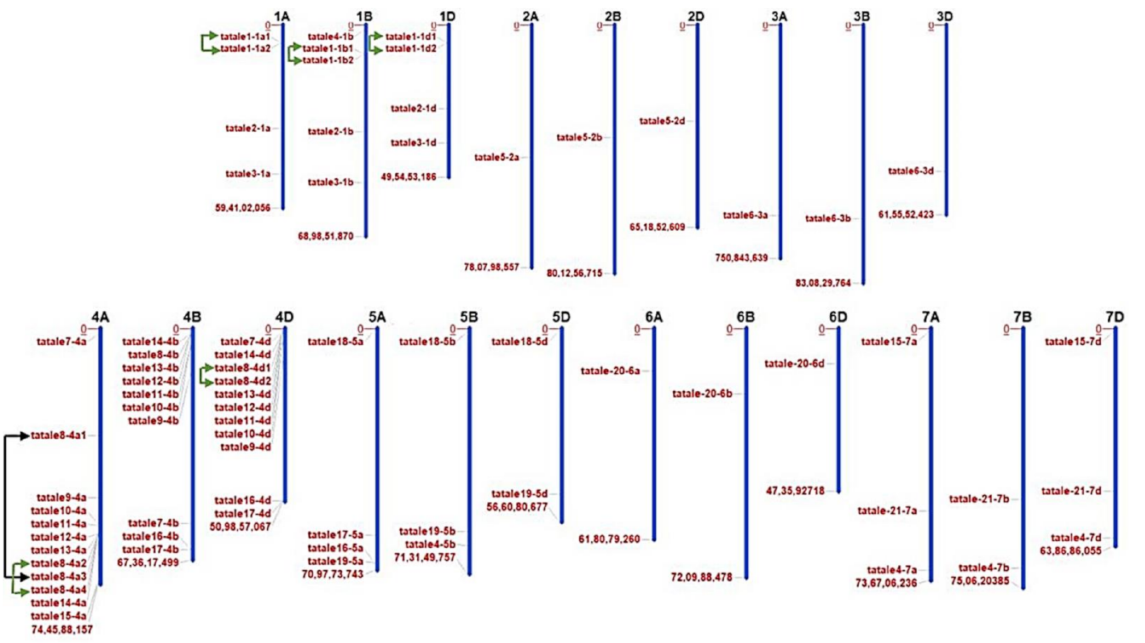
Figure 1. Chromosomal localization and duplication analysis. The location of TaTALE genes on the chromosome and subgenomes (A, B, and D) of bread wheat has been represented on the bar diagrams. The TaTALE genes are distributed on all the chromosomes and subgenomes of bread wheat ( T. aestivum ). Chromosome numbers are shown at the top of each bar. Black and green color curly brackets represent the existence of segmentally and tandemly duplicated genes,